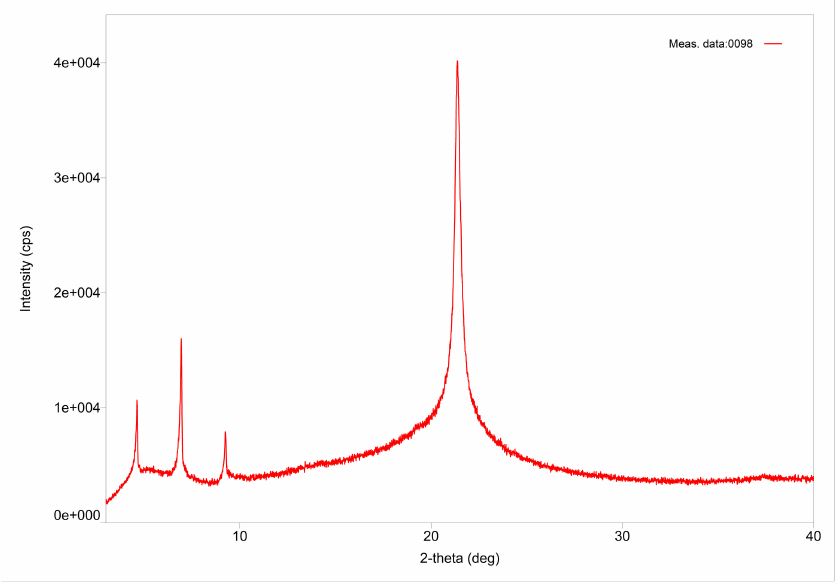
Figure S5: XRPD pattern for sucrose palmitate.